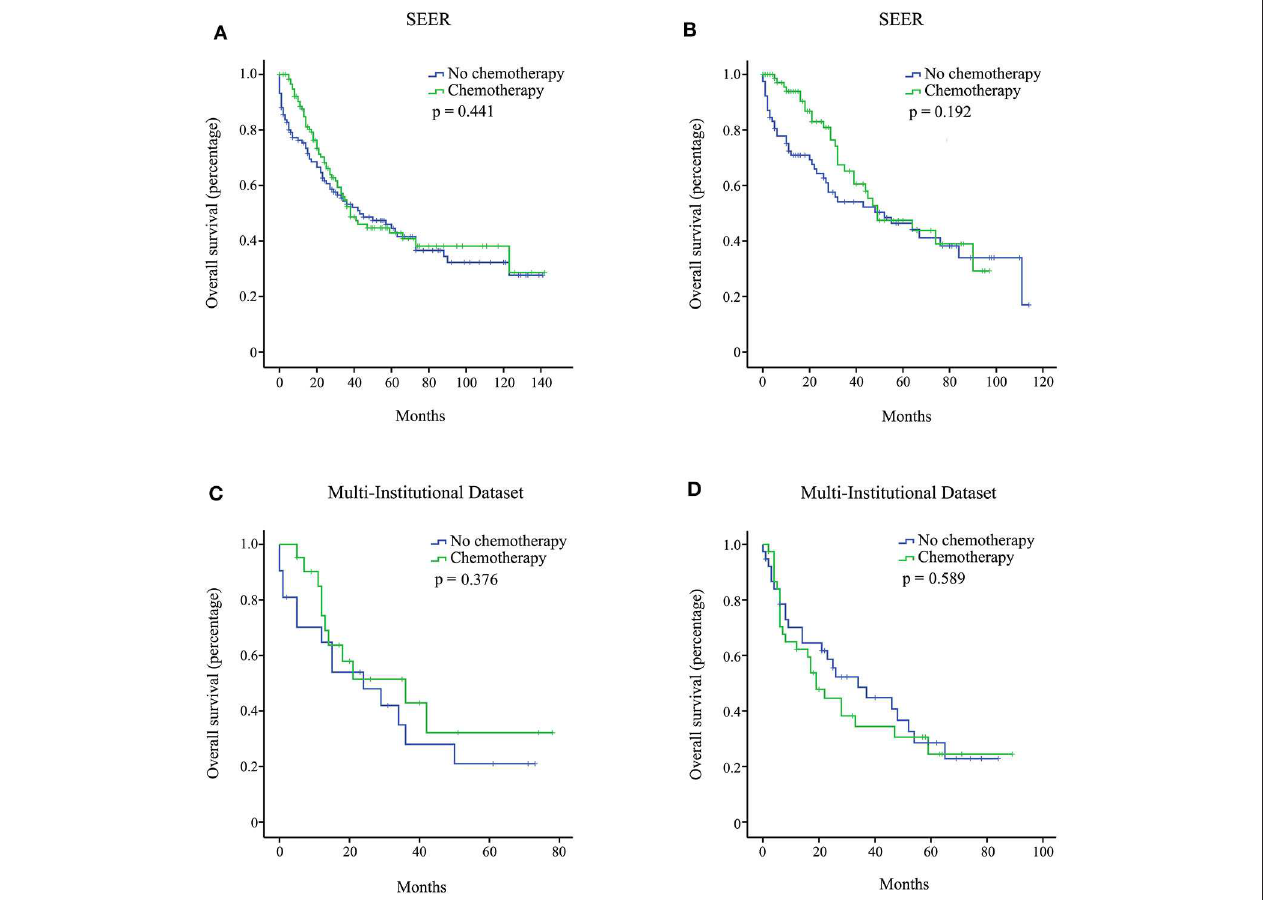
FIGURE 2 | Overall survival (OS) curves for stage IA pancreatic ductal adenocarcinoma (PDAC) patients from the Surveillance, Epidemiology, and End Results (SEER), and multi-institutional dataset after propensity score matching (PSM) adjustment. Stage IA with 15 or more resected lymph nodes from the SEER database (A) ; stage IA with < 15 resected lymph nodes from the SEER database (B) ; stage IA with 15 or more resected lymph nodes from the multi-institutional dataset (C) ; stage IA with < 15 resected lymph nodes from the multi-institutional dataset (D)